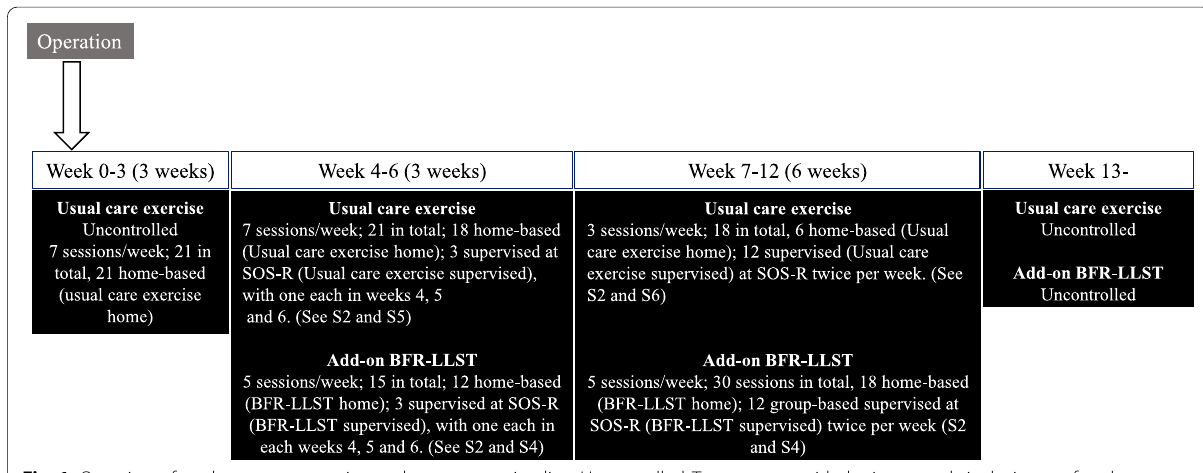
Fig. 1 Overview of study treatment, testing and assessment timeline. Uncontrolled; Treatment provided prior to study inclusion or after the intervention period. SOS-R; Section for Orthopedic and sports Rehabilitation. BFR-LLST; Blood flow restriction – low load strength